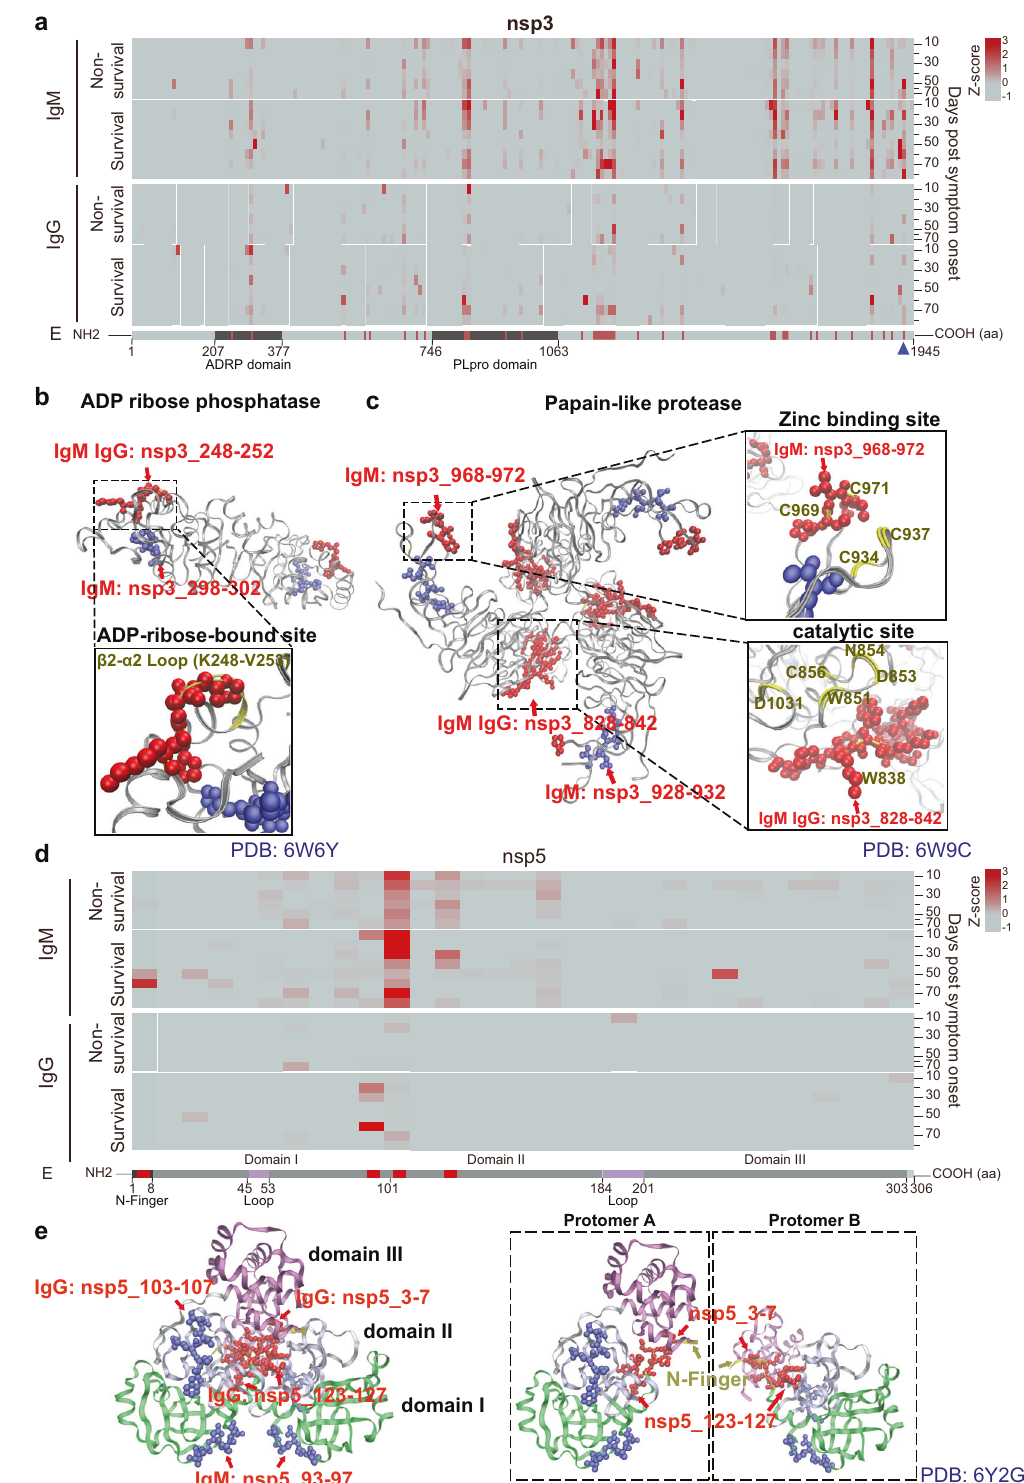
Fig. 4 Dynamic changes of antibody epitopes within SARS-CoV-2 proteases. a Longitudinal changes of IgM and IgG antibody epitopes identi fi ed within the SARS-CoV-2 nsp3 protein. b , c Structural analyses of IgM and IgG epitopes within the ADP ribose phosphatase and papain-like protease, respectively. d Longitudinal changes of IgM and IgG antibody epitopes identi fi ed within the SARS-CoV-2 nsp5 protein. e Structural analyses of IgM and IgG epitopes within the nsp5 protein. The epitopes within the functional domain that may interfere the protein activity are labeled in red. ADRP ADP-ribose phosphatase domain, PLpro papain-like protease